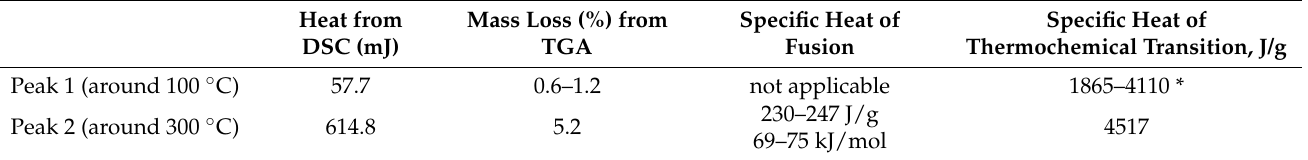
Table 1. Heat measured by DSC, % mass loss from TGA and specific heat of fusion and thermochemi- cal transition for the two endothermic peaks detected in the DSC curve of